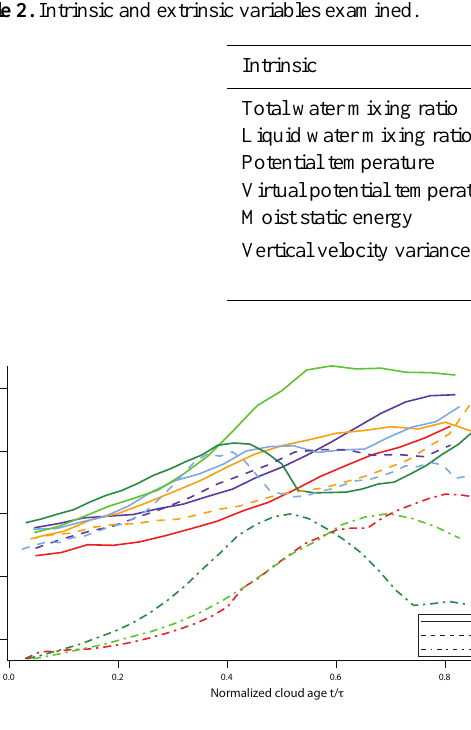
Figure 5. Time series of volume-averaged potential temperature. Figure 6. Time series of the altitude of liquid water cloud center of